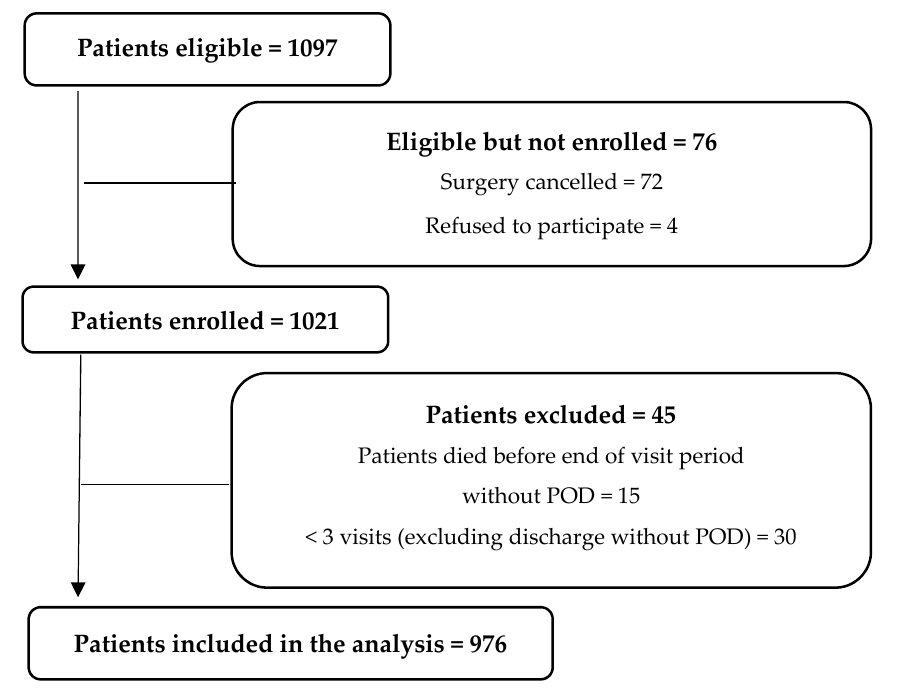
Figure 1. Flow diagram. Table 1. Characteristics variables related to